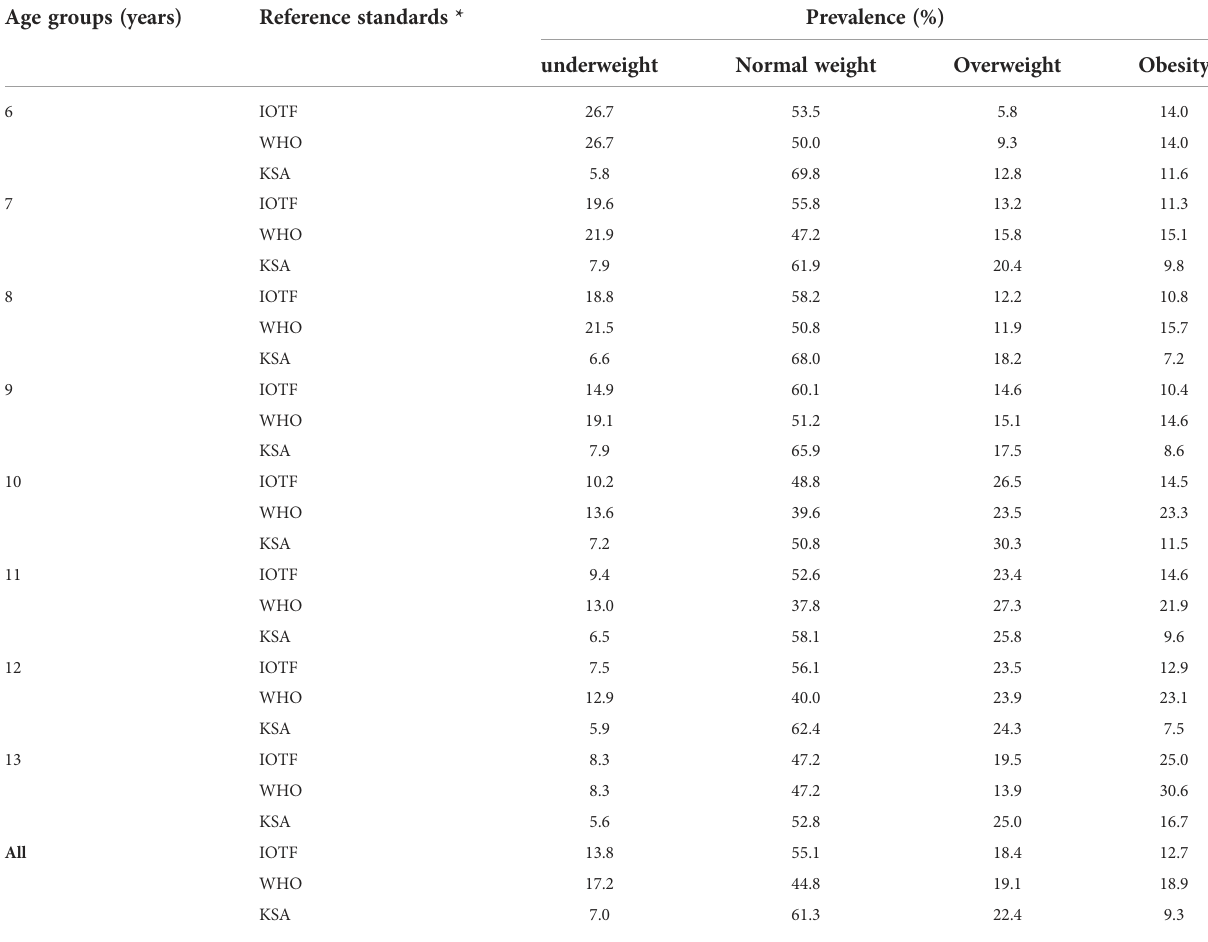
TABLE 2 The prevalence of underweight, normal weight, overweight, and obesity among Saudi children using IOTF or WHO reference standards relative to age. Age groups